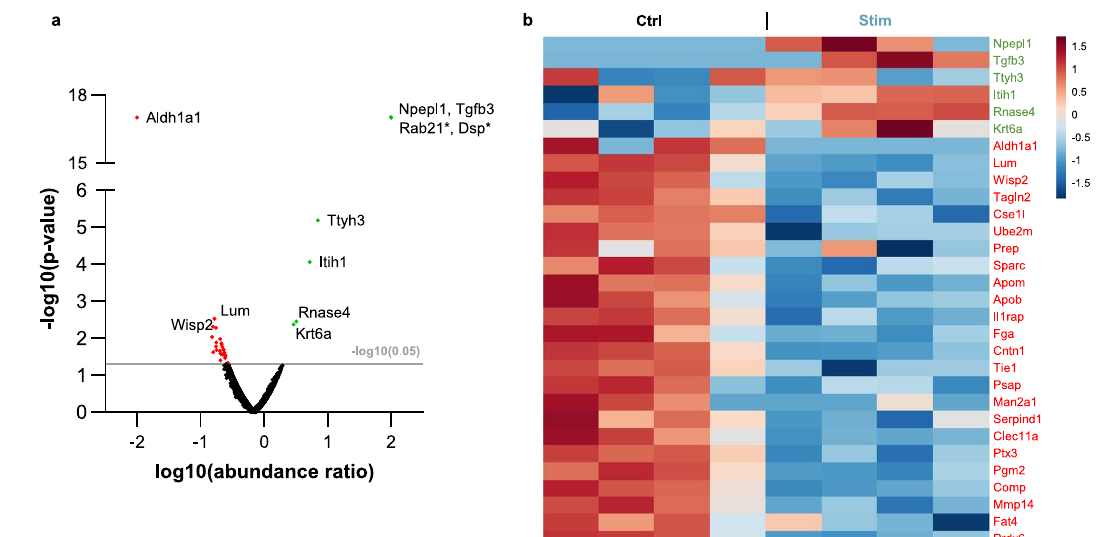
Fig. 4 Proteomic analyses of osteoblast-secreted matrix microvesicles. a Volcano plot analysis of the 943 proteins identi fi ed by mass spectrometry. From these, 32 were signi fi cantly deregulated under Stim condition relatively to Ctrl : 8 proteins were considered signi fi cantly upregulated by HF stimulation, with abundance Stim / Ctrl ratios ≥ 2 (in green); 24 proteins were considered signi fi cantly downregulated by HF stimulation, with abundance Stim / Ctrl ratios ≤ 0.5 (in red; only the three top genes are identi fi ed in the graph). Data are plotted considering the log10 of the abundance Stim/Ctrl ratio and the − log10 of its P value ( n = 4). The gray line at − log10 (0.05) represents the signi fi cance cut-off ( P value = 0.05). Proteins marked with * were only detected in one sample from Stim condition. b Heatmap representing the relative abundance per sample of the 30 deregulated proteins detected in more than one sample per condition. Normalized abundances were log10 transformed and standardized for visualization of expression trends ( n = 4). Proteins are sorted by the P value of their Stim/Ctrl ratio of relative abundances, and these values are color